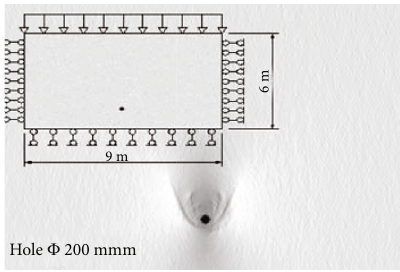
Figure 5: 200-mm maximum principal stress for